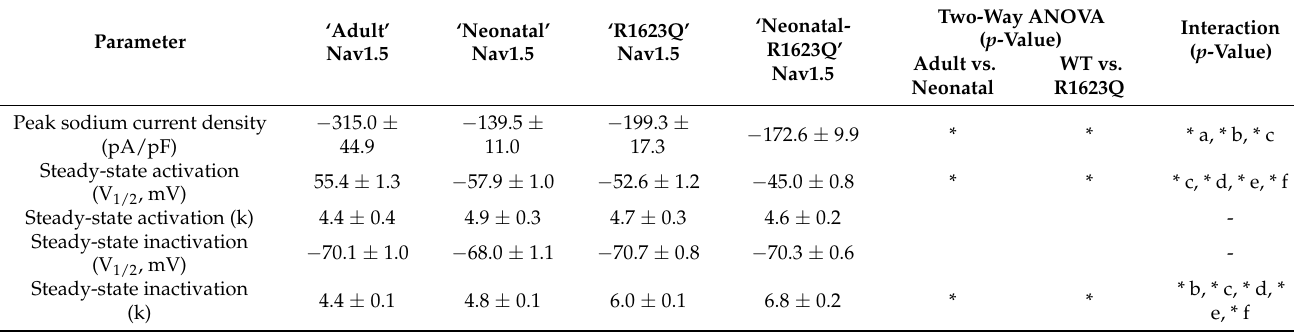
Table 1. Summary of electrophysiological